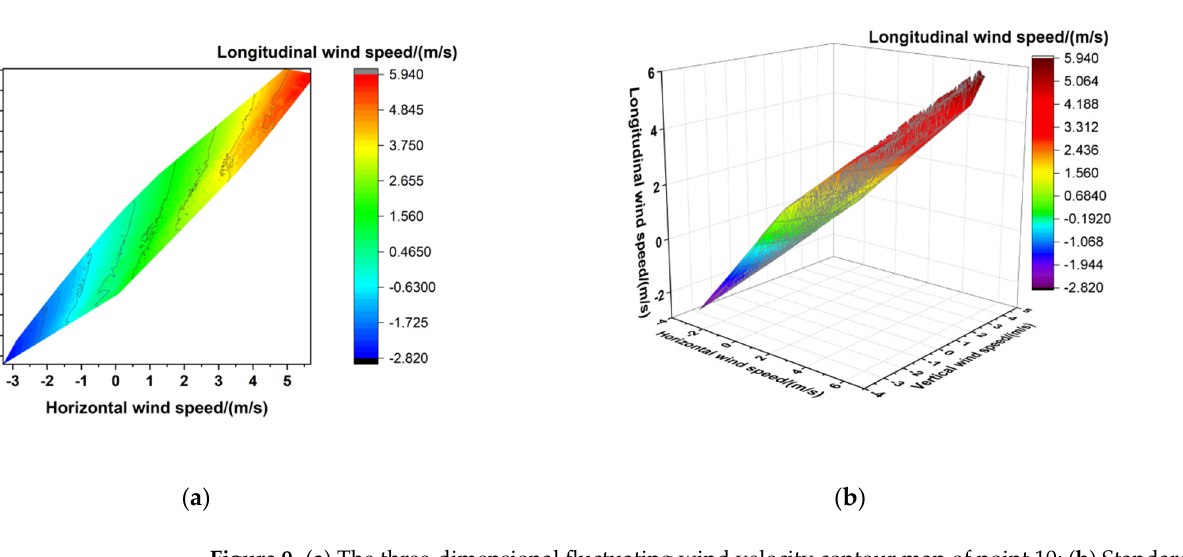
Figure 9. ( a ) The three-dimensional fluctuating wind velocity contour map of point 10; ( b ) Standard The three-dimensional fluctuating wind velocity 3D surface of point 10.